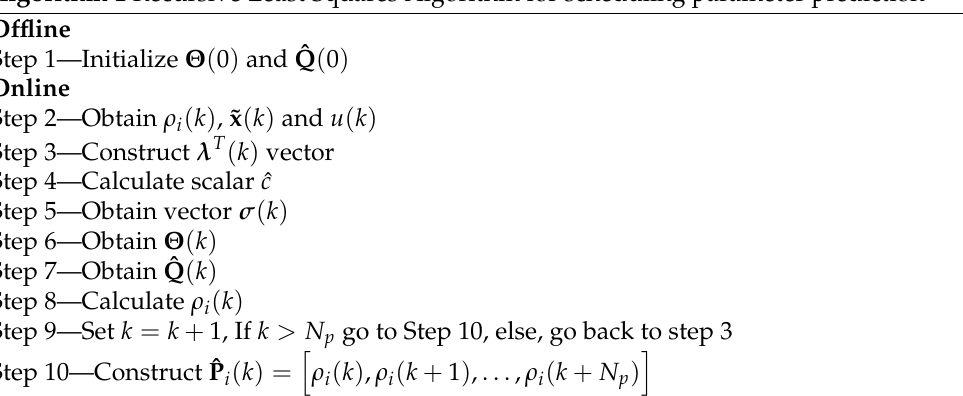
Algorithm 1 Recursive Least Squares Algorithm for scheduling parameter